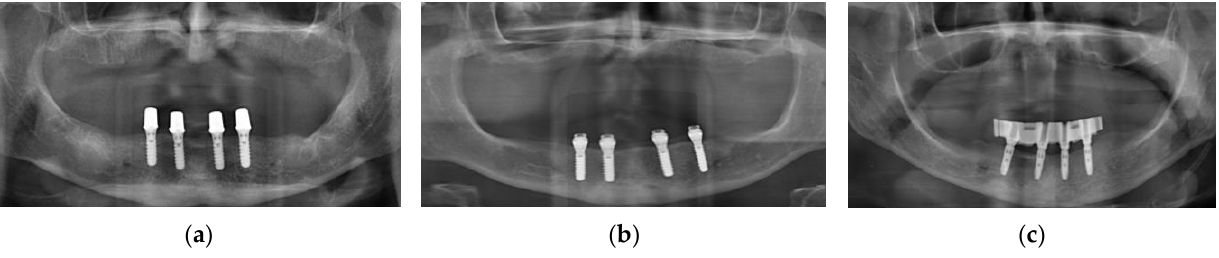
Figure 2. Typical patient situations with implant-supported overdentures analyzed in the first part of the study. ( a ) Telescopic crowns used as attachment system; ( b ) Locator-type attachments